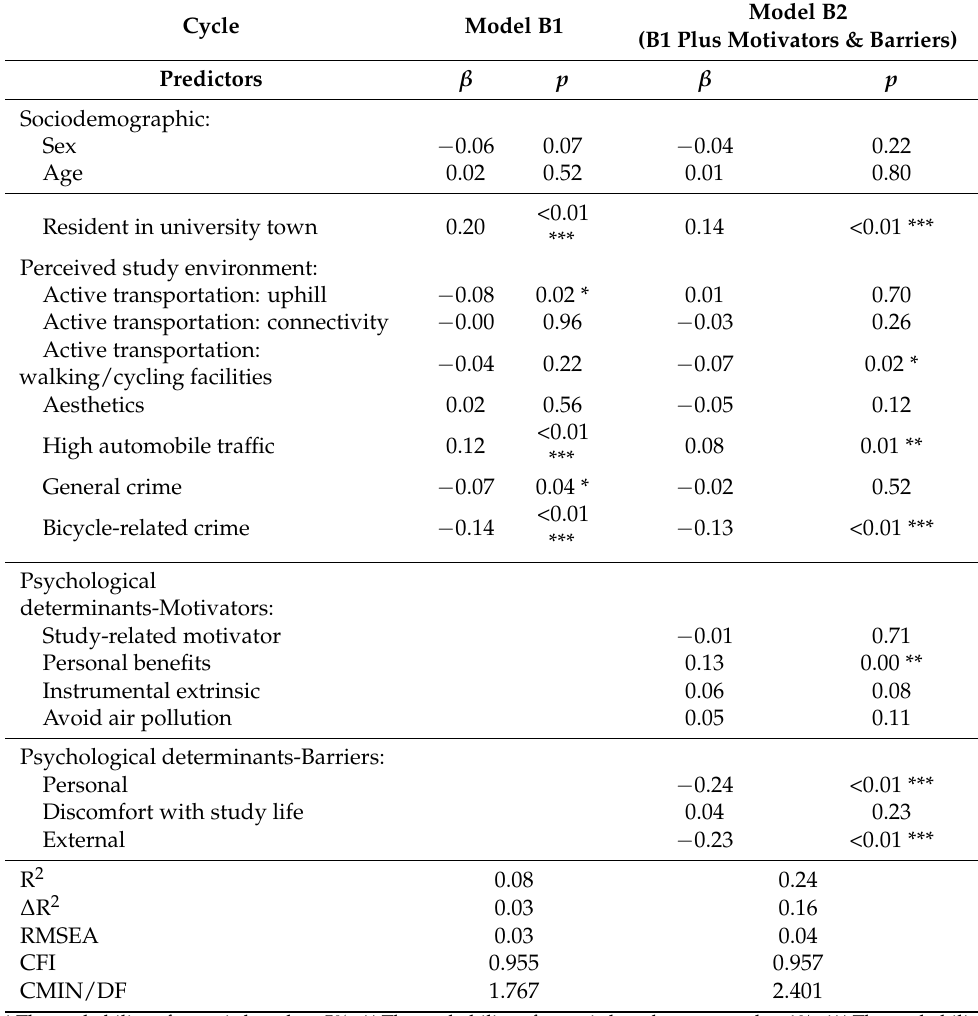
Table 3. Results of the blockwise multivariate regression models B1 (predictors—sociodemographics, and perceived study environment) and B2 (A1 plus motivators & barriers) for the active transportation by cycling. Model B2 Cycle Model B1 (B1 Plus Motivators &